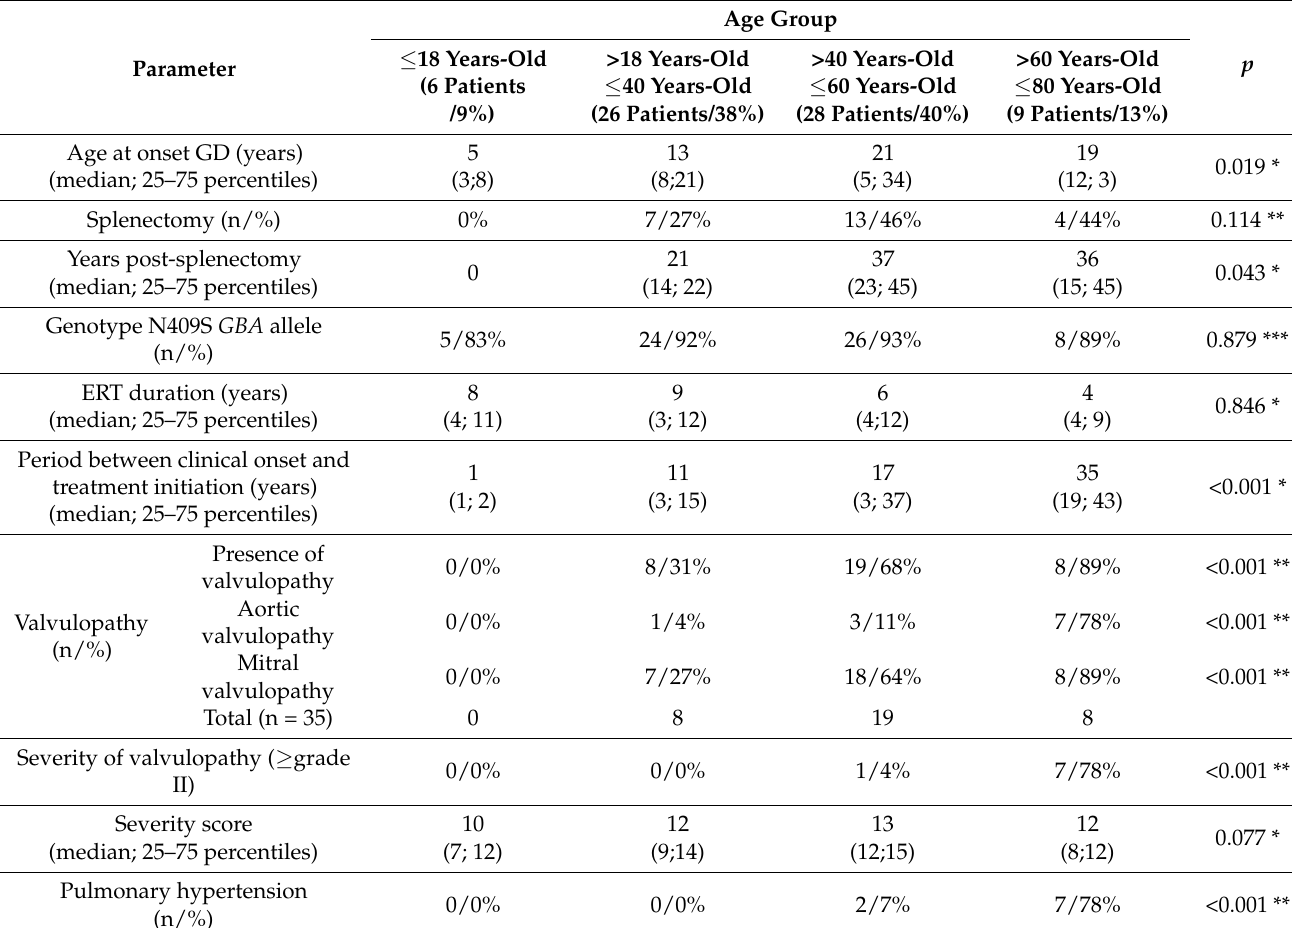
Table 4. Clinical characteristics and cardiac involvement of Gaucher patients depending on